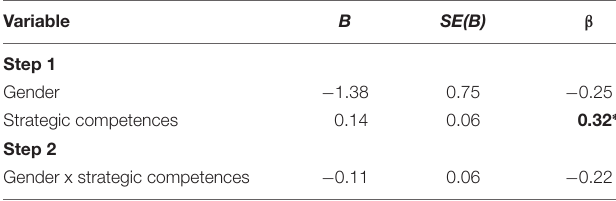
TABLE 3 | Hierarchical regression predicting situational interest ( N = 56).